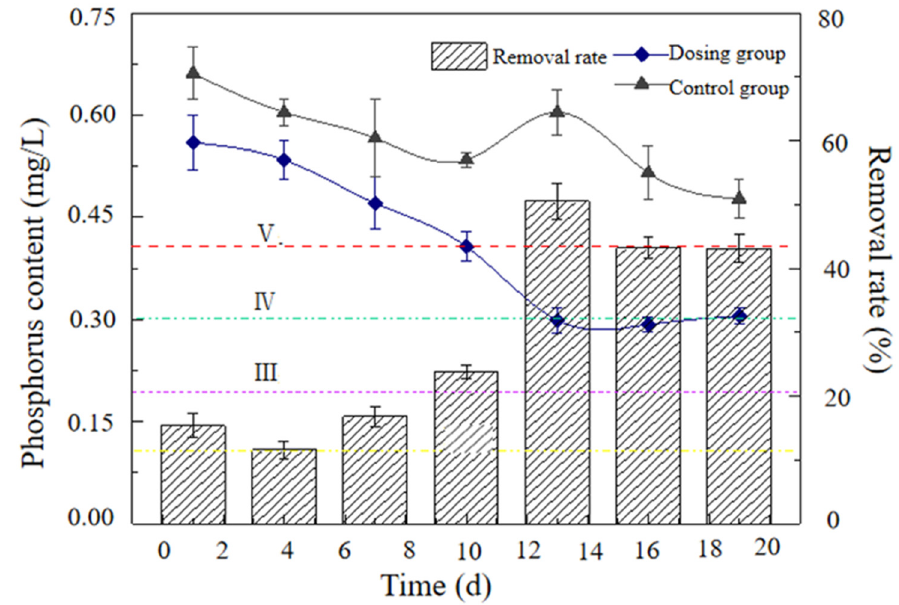
Figure 8. Total phosphorus effect control comparison chart.